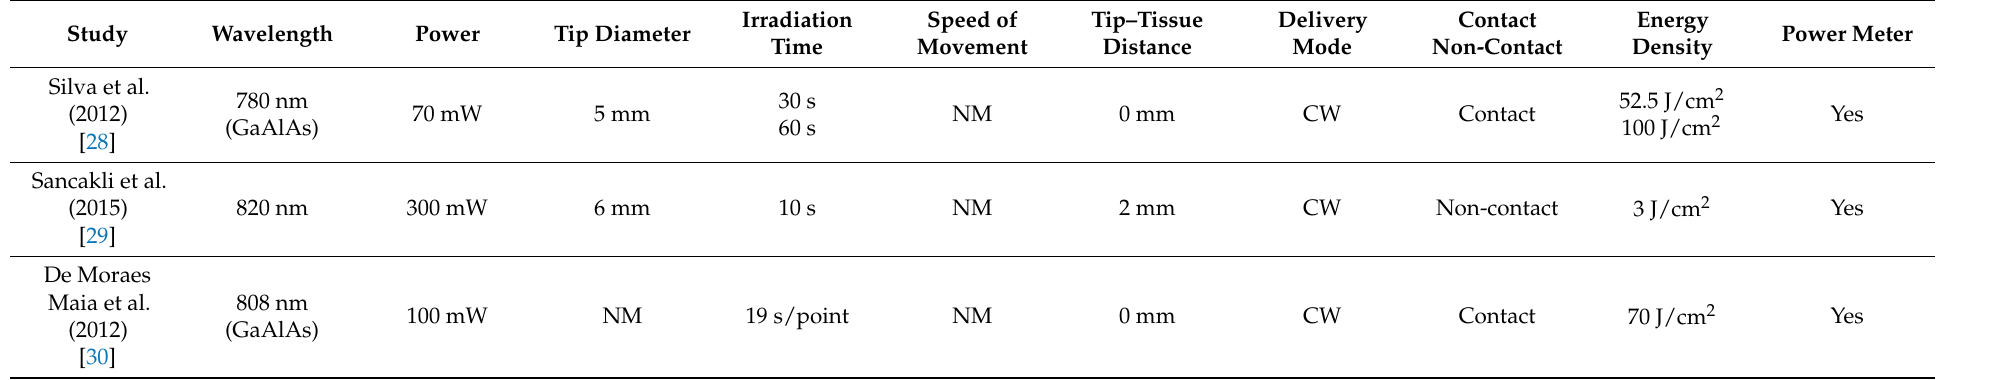
Table 2. Details of laser parameters in the included studies. NM, not mentioned; GaAlAs, gallium-aluminum-arsenide; nm, nanometer; W, watt; mW, milli-watt;